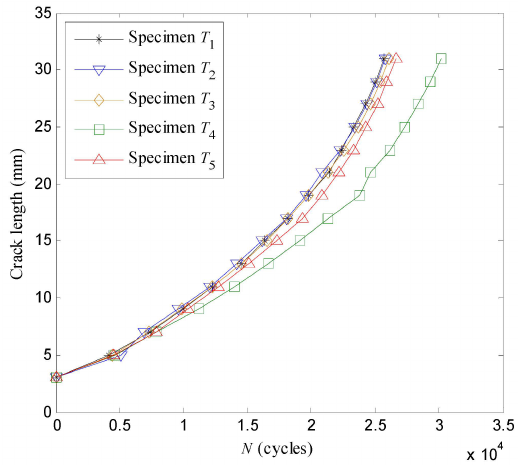
Figure 9. The crack lengths versus the loading cycles.